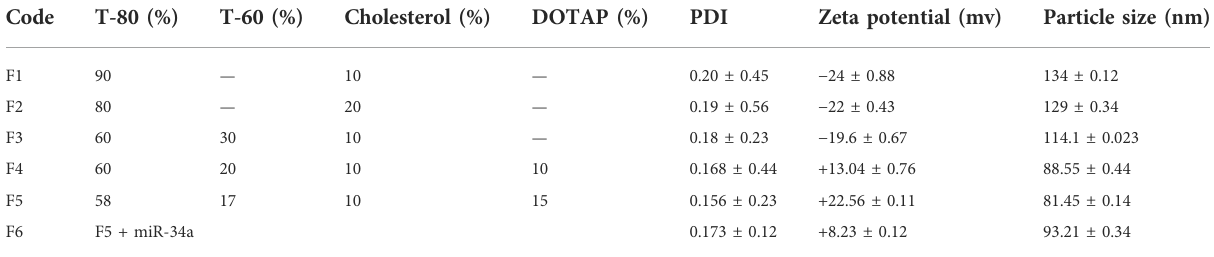
TABLE 2 The effect(s) of T-80:T-60:cholesterol ratio on the PDI, zeta potential (mV), and particle size (nm) in miRNA-niosome particles.